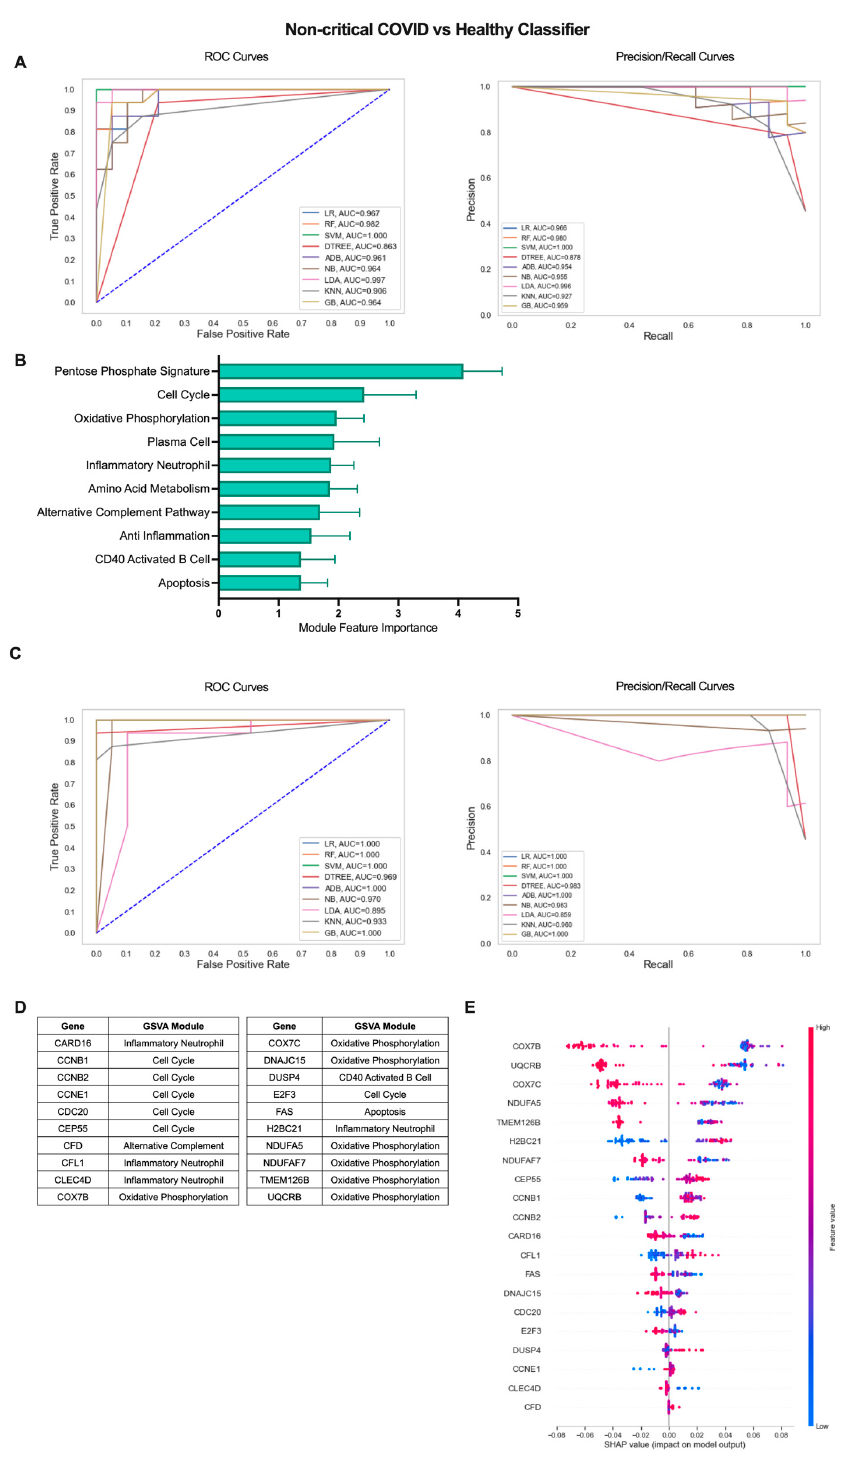
Figure 3. Iterative ML non-critical COVID-19 patient vs. healthy individual classifier results. ( A ) Representative ROC and PR curves from the first ML pipeline iteration for the non-critical COVID-19 patient vs. healthy control classifier. ( B ) Bar graph of feature importance values for the top 10 gene modules resulting from the second ML pipeline iteration. ( C ) Representative ROC and PR curves from the third ML pipeline iteration for the non-critical COVID-19 patient vs. healthy control classifier. ( D ) Top 20 gene features resulting from the third ML pipeline iteration. ( E ) SHAP summary plot depicting the magnitude and directionality of relationships between the top 20 gene features and non-critical COVID-19 classification.